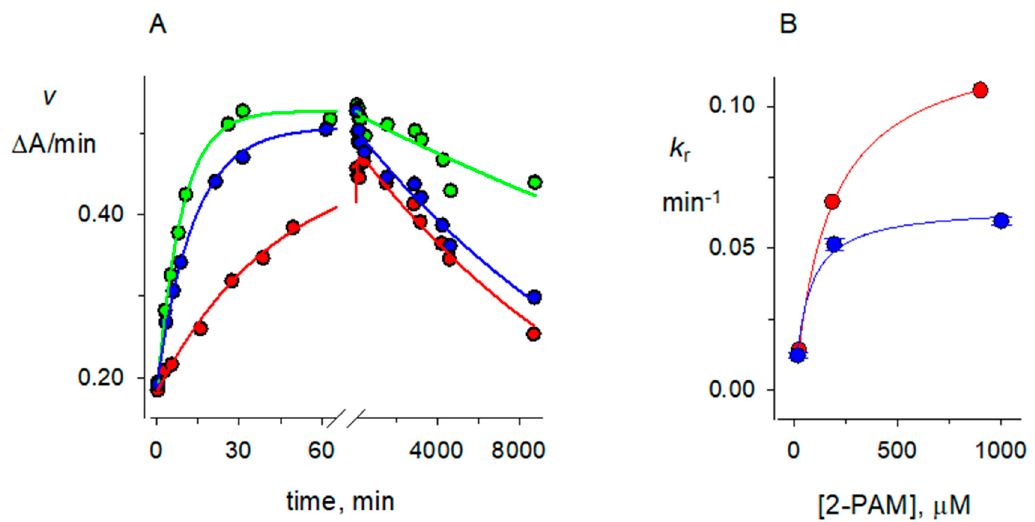
Figure 5. 2-PAM reactivation of dimethylphosphorylated AChE in H 2 O. A mixture of 1.6 µ M paraoxon Figure 5. 2 ‐ PAM reactivation of dimethylphosphorylated AChE in H 2 O. A mixture of 1.6 μ M methyl and 1.5 µ M AChE in 100 mM sodium phosphate and 0.1% BSA (bu ff er) in H 2 O (pH 8.0) was paraoxon methyl and 1.5 μ M AChE in 100 mM sodium phosphate and 0.1% BSA (buffer) in H 2 O (pH incubated for 30 min at 25 ◦ C. A 2.5-fold excess of bu ff er in H 2 O was added, and 100 µ L was applied